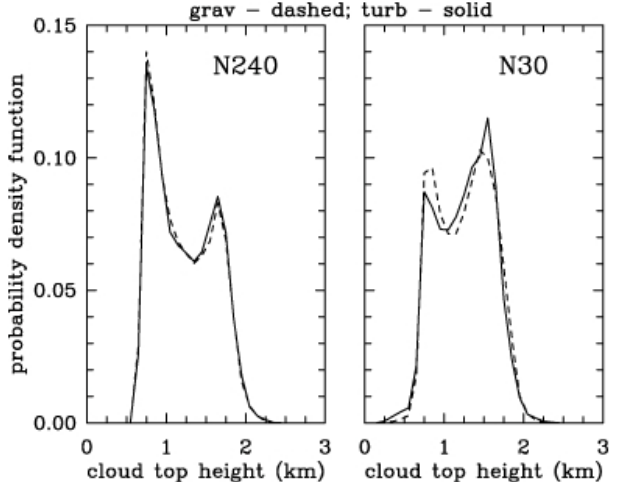
Fig. 13. Probability density function of the cloud top height: sim- ulation N 240 (left panel) and N 30 (right panel); the gravitational and turbulent kernels are denoted by dashed and continuous lines, respectively.